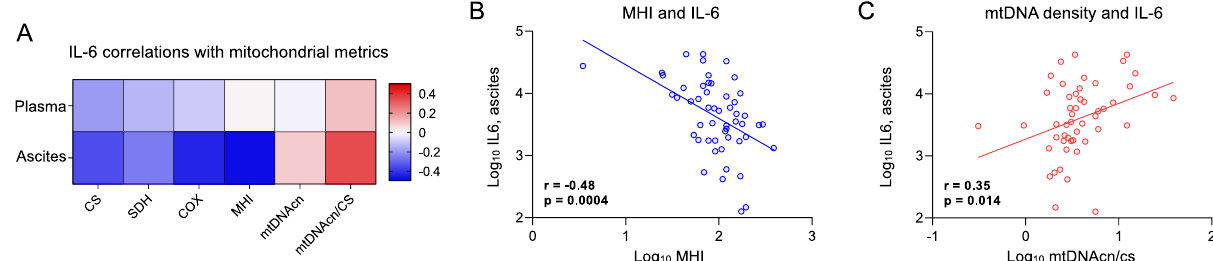
Figure 4. Mitochondrial measures and IL-6 in high-grade epithelial ovarian carcinoma. ( A ) Pearson correlations between mitochondrial measures and IL-6 levels measured in ascites and plasma. Note the similar patterns of correlation between ascites and plasma, and the contrast in the associations between mtDNA-related measures (positive) and primary measures of mitochondrial content and respiratory chain function (negative). ( B ) Scatterplots of the correlations between ascites IL-6 levels and the mitochondrial health index (MHI), and ( C ) mtDNA density per mitochondrion (mtDNAcn/CS). n = 50–64 for ascites, 82–110 for